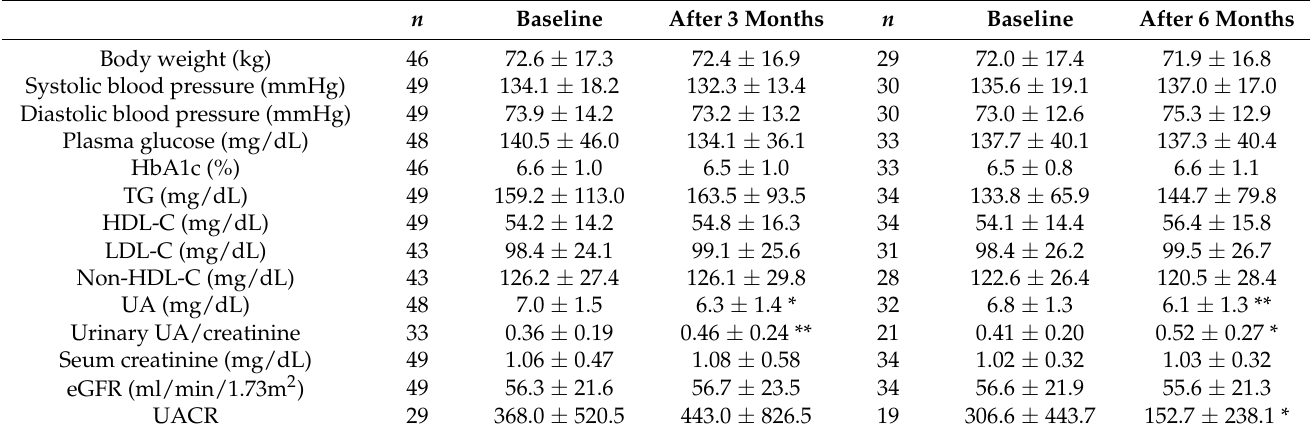
Table 6. Changes in metabolic parameters after the start of dotinurad in patients who had taken anti-hypertensive drugs ( n = 50). n Baseline After 3 Months n Baseline After 6 Months